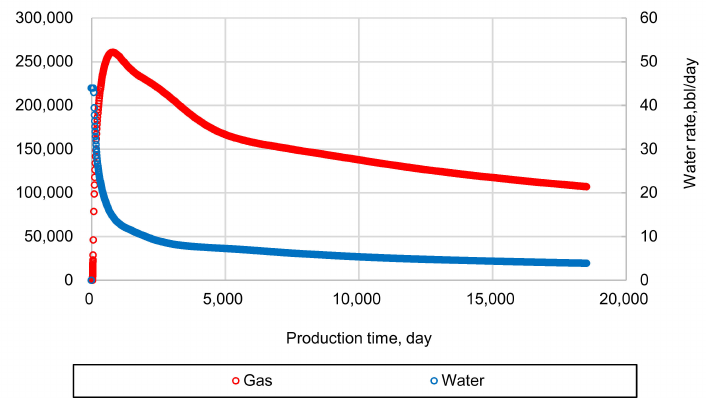
Figure 6. Simulated production rate of a horizontal well in an under-saturated CSG